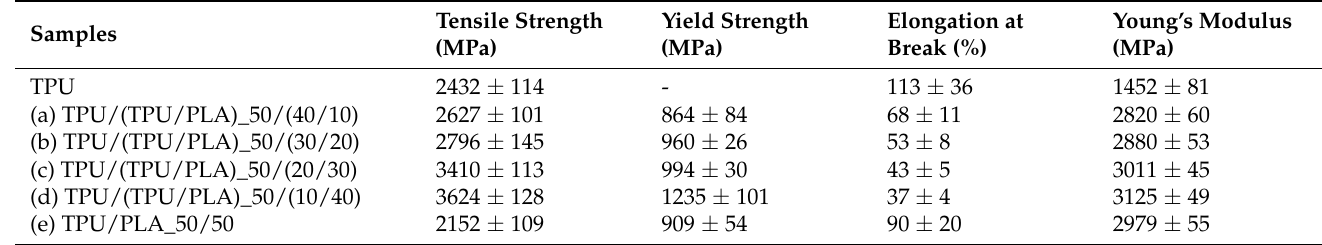
Figure 10. Stress–strain curves of TPU fiber and TPU(TPU/PLA) bicomponent fibers. Figure 10. Stress – strain curves of TPU fiber and TPU(TPU/PLA) bicomponent fibers. Table 4. Mechanical properties of TPU fiber and TPU(TPU/PLA) bicomponent Table 4. Mechanical properties of TPU fiber and TPU(TPU/PLA) bicomponent fibers.